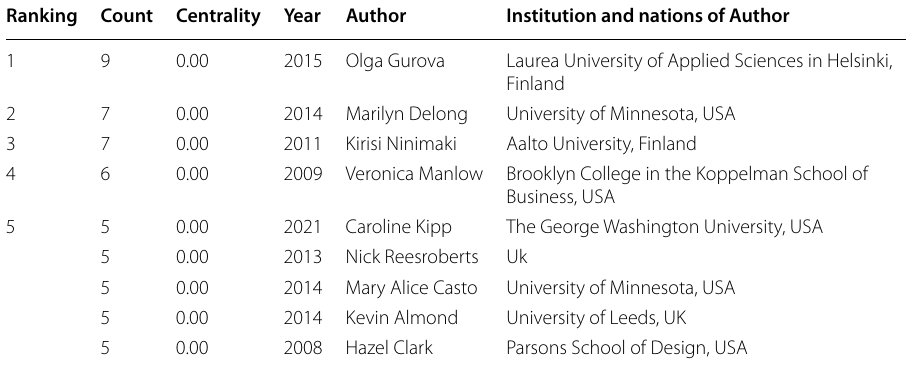
Table 1 Top productive authors of “fashion design”‑related articles Ranking Count Centrality Year